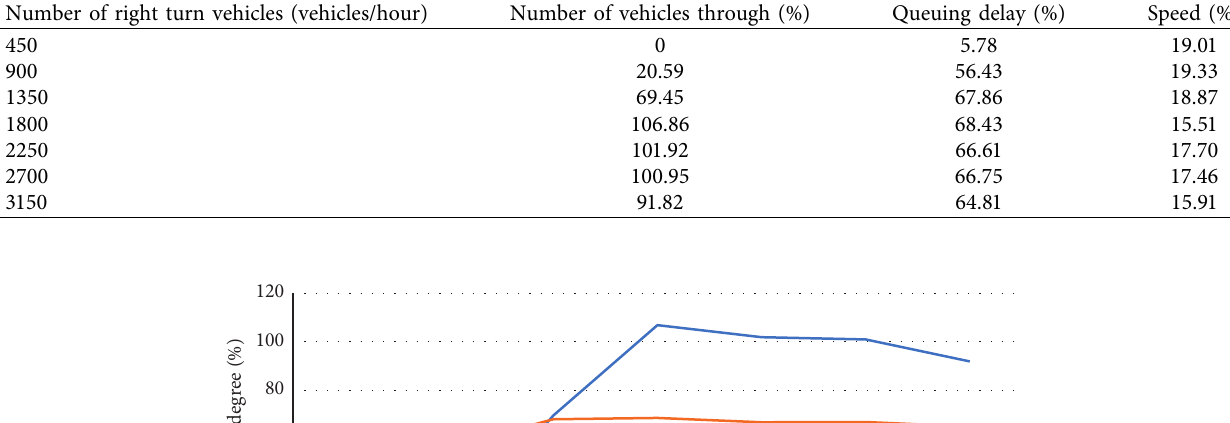
Table 6: Optimization degree of the original scheme with different number of vehicles turning from west to right. Number of right turn vehicles (vehicles/hour)